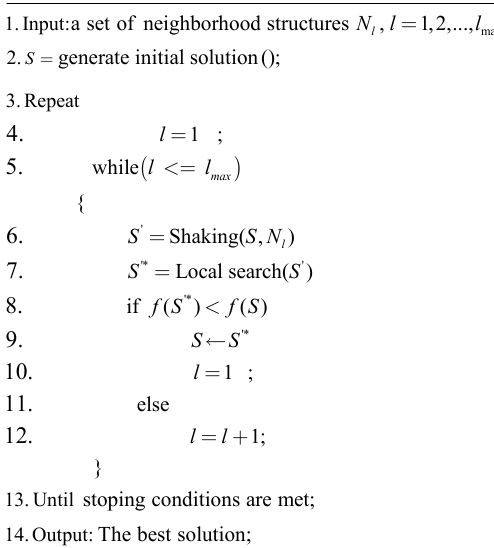
Fig. 4. Pseudo-code of the VNS